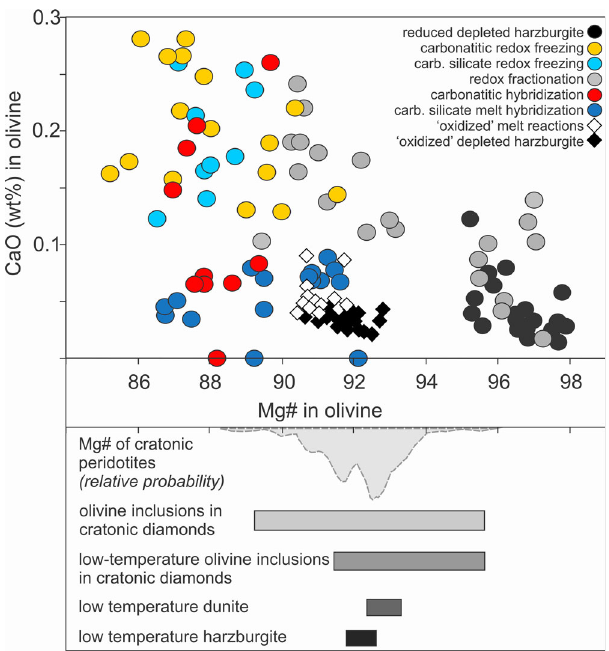
Fig. 3 CaO content versus Mg# of the olivines from the redox freezing, redox fractionation, and hybridization zones. Low temperature cratonic dunites and harzburgites 33 , diamond inclusions 41